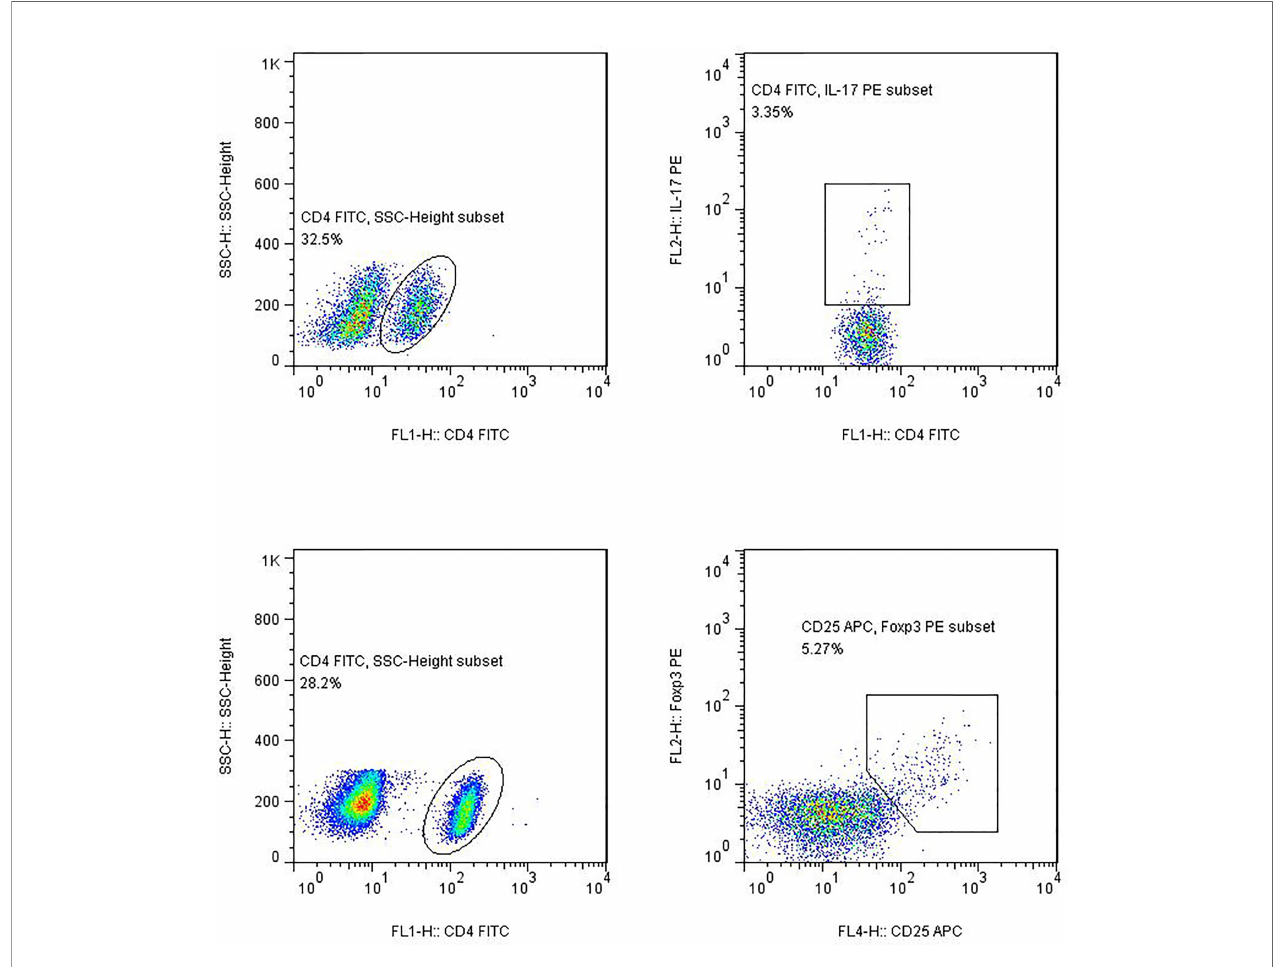
FIGURE 1 | Gating for Th17 cells and Treg